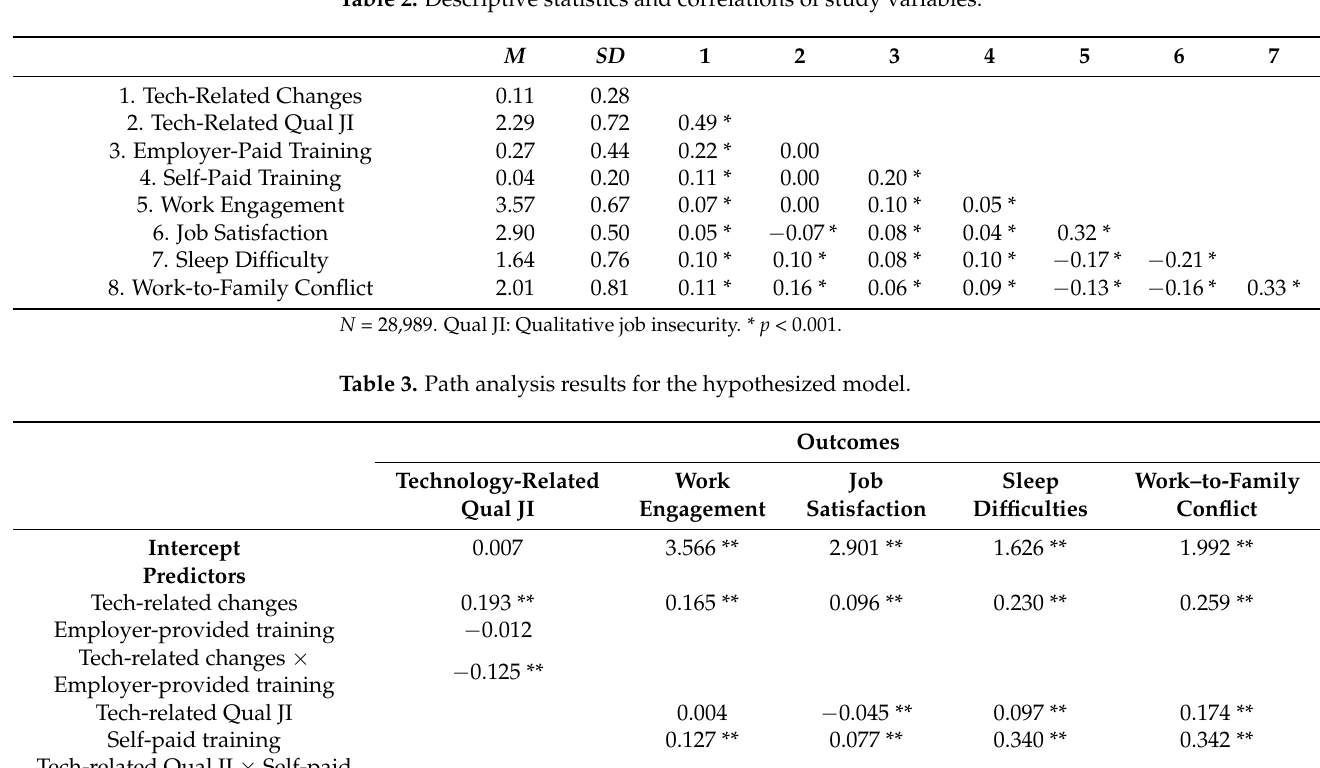
Table 2. Descriptive statistics and correlations of study variables.